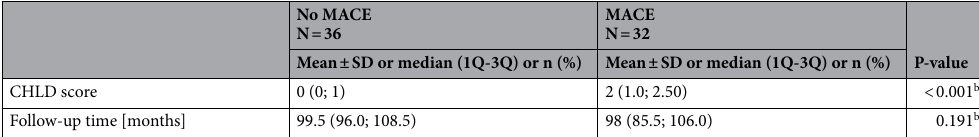
Table 1. Demographic and clinical characteristics in patients with and without major adverse cardiovascular events in long-term follow-up. 6MWT: 6-min walk test; ACE: angiotensin-converting enzyme; ANA: antinuclear antibodies; ACA: anticentromere antibodies DLCO: diffusing capacity for carbon monoxide; FVC: forced vital capacity; GDF-15: growth differentiation factor 15; HRCT: high-resolution chest tomography; NSAIDs: non-steroidal anti-inflammatory drugs; NT-proBNP: N-terminal pro-B-type natriuretic peptide; FMD: flow-mediated dilation; NMD: nitrate-mediated dilation; PWV: pulse wave velocity; CHLD: chronic kidney disease, arterial hypertension, hyperlipidaemia and diabetes mellitus score; LA-left atrial diameter; LAA: left atrial area; LVEF: left ventricular ejection fraction; LV: left ventricular; RAA: right atrial area; RVSP: right ventricular systolic pressure; SSc: systemic sclerosis; TLC: total lung capacity. a Chi-square test; b Mann- Whitney U